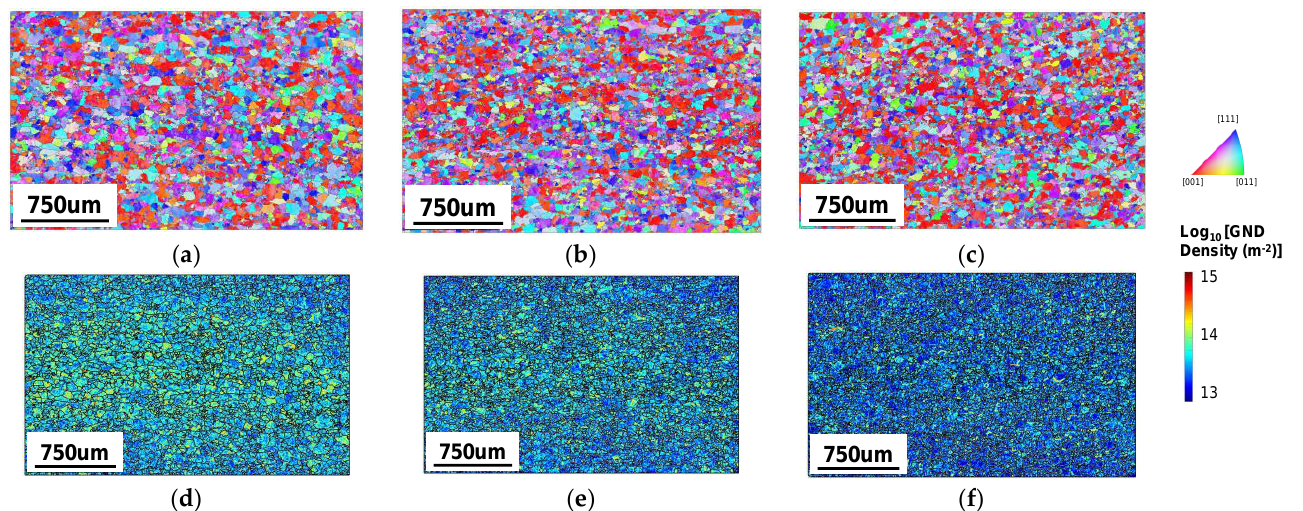
Figure 5. EBSD IPFX images for samples hot deformed to a true strain level of 0.3 at ( a ) 300 °C, ( b ) 350 °C and ( c ) 400 °C and the corresponding GND maps ( d–f ). The strain rate is 1/s.